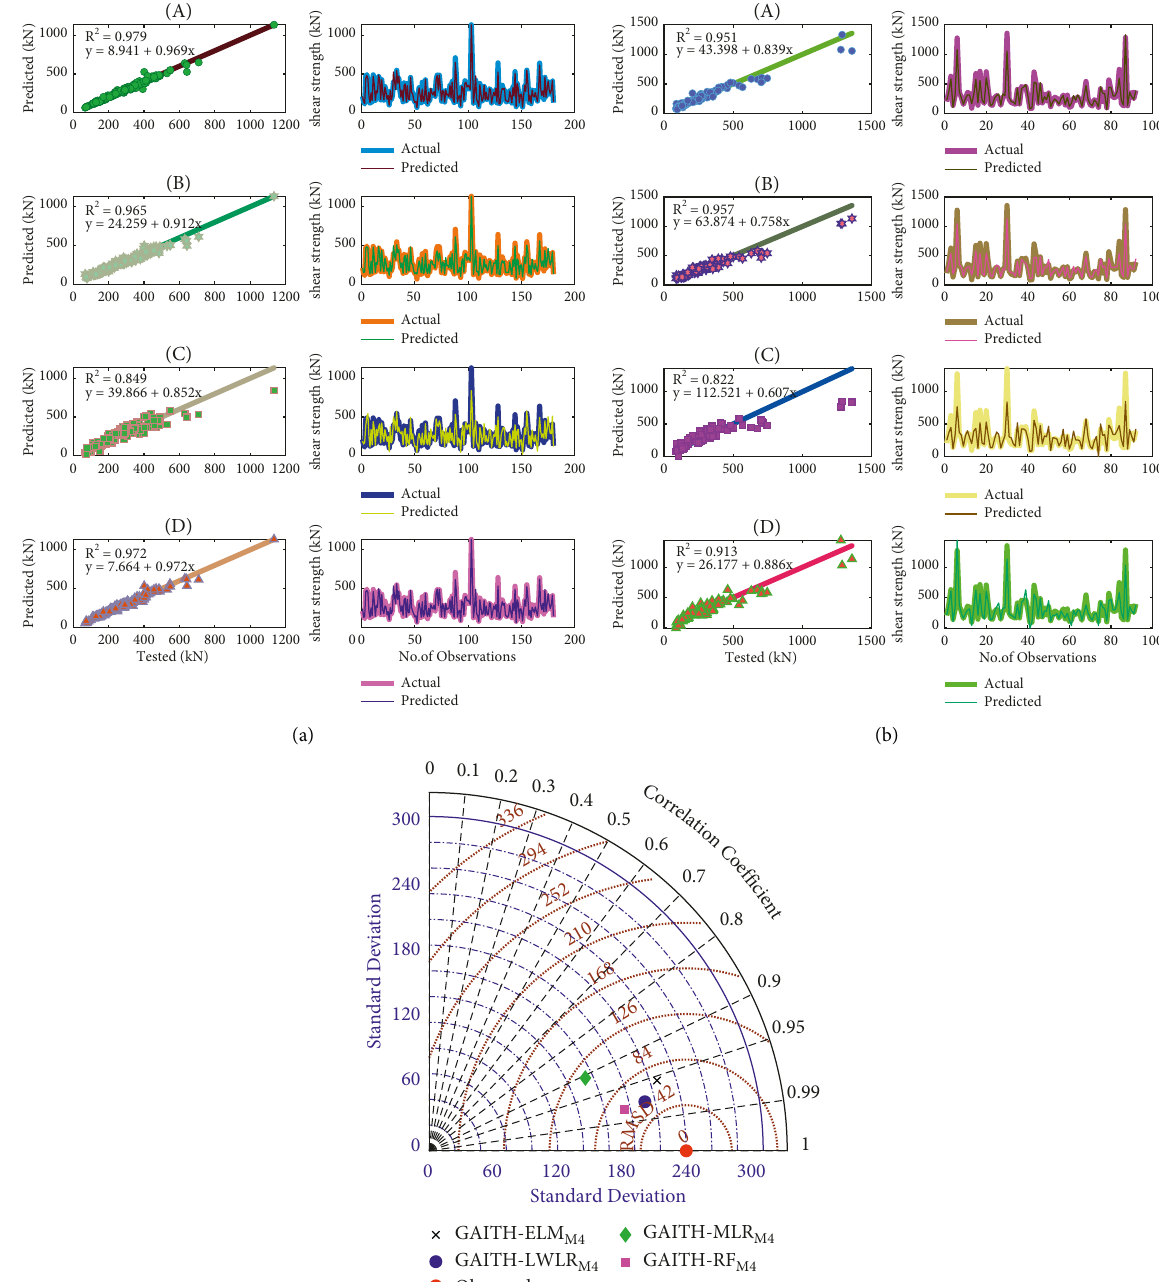
Figure 10: A comparison between the objectives of the models: (A)–(D) represent the GLWLR , and GAITH − ELM GAITH − MLR M M 4 models, respectively. Figures (a) and (b) show scatter plots and line plots for the training and test 4 data, respectively, while figure (c) is a Taylor plot based on the test data. (a) Training data. (b) Testing data. (c) Taylor